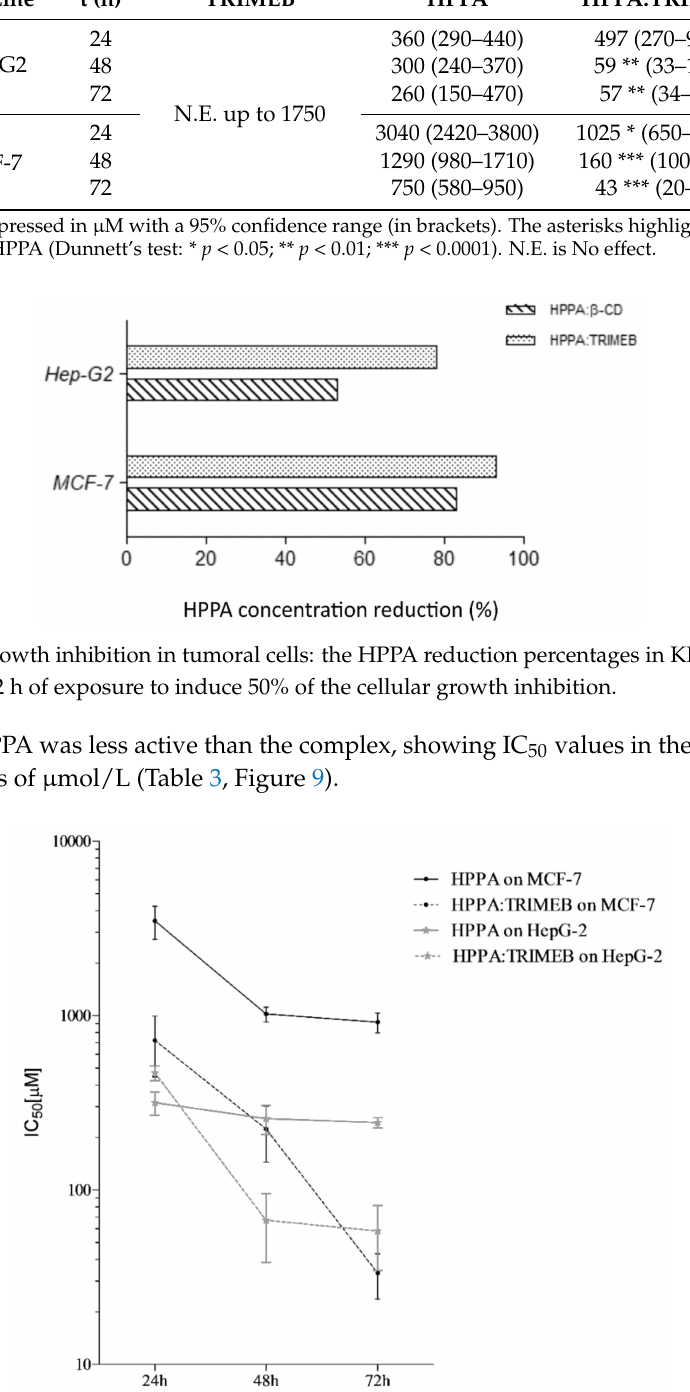
Figure 9. The antitumor activity expressed as IC50 ( µ M) against MCF-7 and HepG2 cells of HPPA and HPPA:TRIMEB after 24, 48, and 72 h of co-incubation. The trends are from the interpolation of the three independent experiments, using GraphPad Prism 5. The results are expressed in µ M. The bars represent the standard